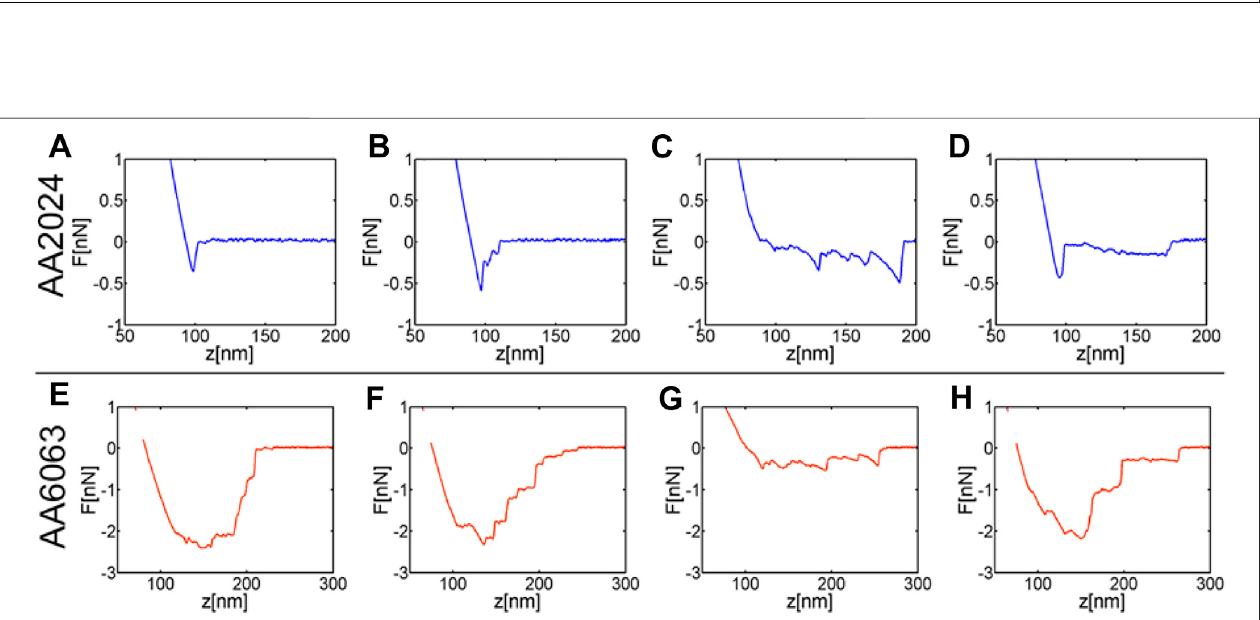
FIGURE 6 | Typical force curves obtained at pH 6.0 for AA2024 and AA6063 alloys reveal bacterial adhesion. Single rupture bonds (A, B) . Multiple force peaks (C – G) forming sawtooth patterns often superimposed ontoconstantforceplateaus (D) : asapilus segmentispulled,atypical nonlinear extension curvecharacteristicof entropic elasticity (C – G) is revealed, while fast unloading signatures the rupture of a pilus bonds at the surface. Zipper-like adhesion re fl ected by the sequential detachment of multiple pili-surface bonds leading to force plateaus (D) , sometimes these plateaus superimpose onto one another (F – H) .